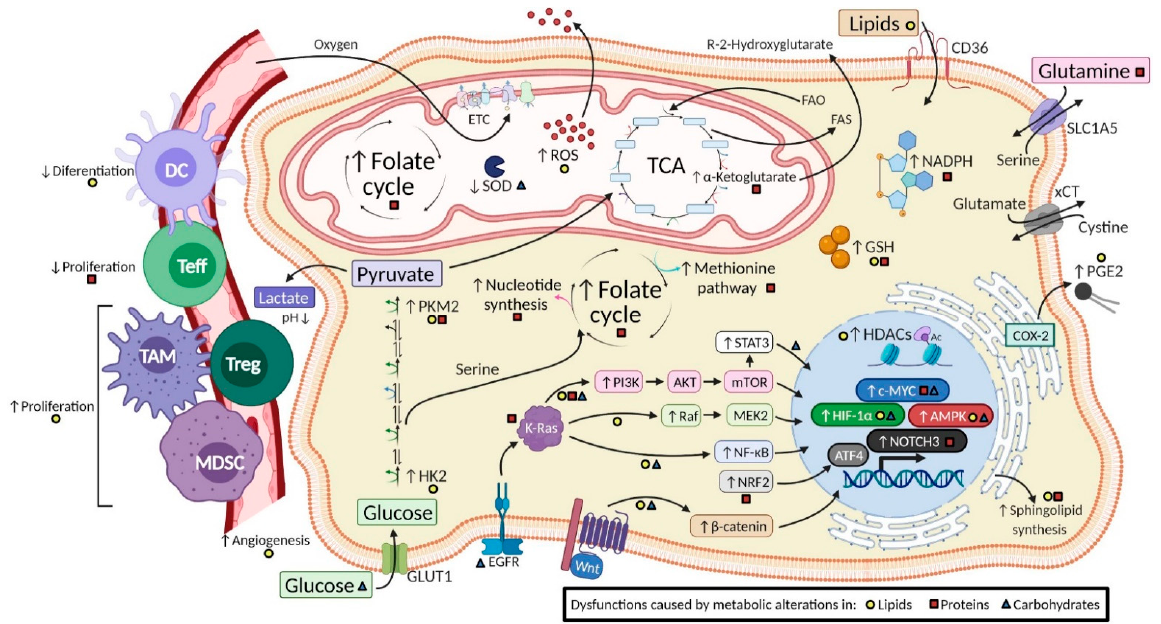
Figure 1. Summary of alterations of metabolic pathways in tumor cells and subsequent changes in cellular processes and the tumor microenvironment. The diagram shows a selection of the tumor metabolic alterations in lipids, proteins, and carbohydrates described in the text. Some subsequent regulations caused by metabolic modifications within the cell are highlighted, such as changes in molecular pathways, transcription factors, and biomolecules and in the tumor microenvironment caused by immune cells, blood vessels, and changes in pH. The yellow circle, red square, and blue triangle indicate that the change is promoted by metabolic alteration in lipids, proteins, and carbohydrates, respectively. The schema is based on data from the literature review. Certain cellular and microenvironmental tumor alterations can also be attributed to other metabolic alterations not mentioned in this review. DC: Dendritic cells; ETC: Electron Transport